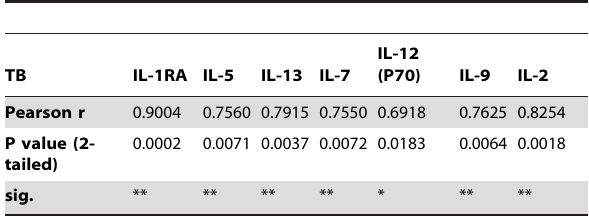
Table 3. Cytokines showing significant correlations with IFN- c in TB